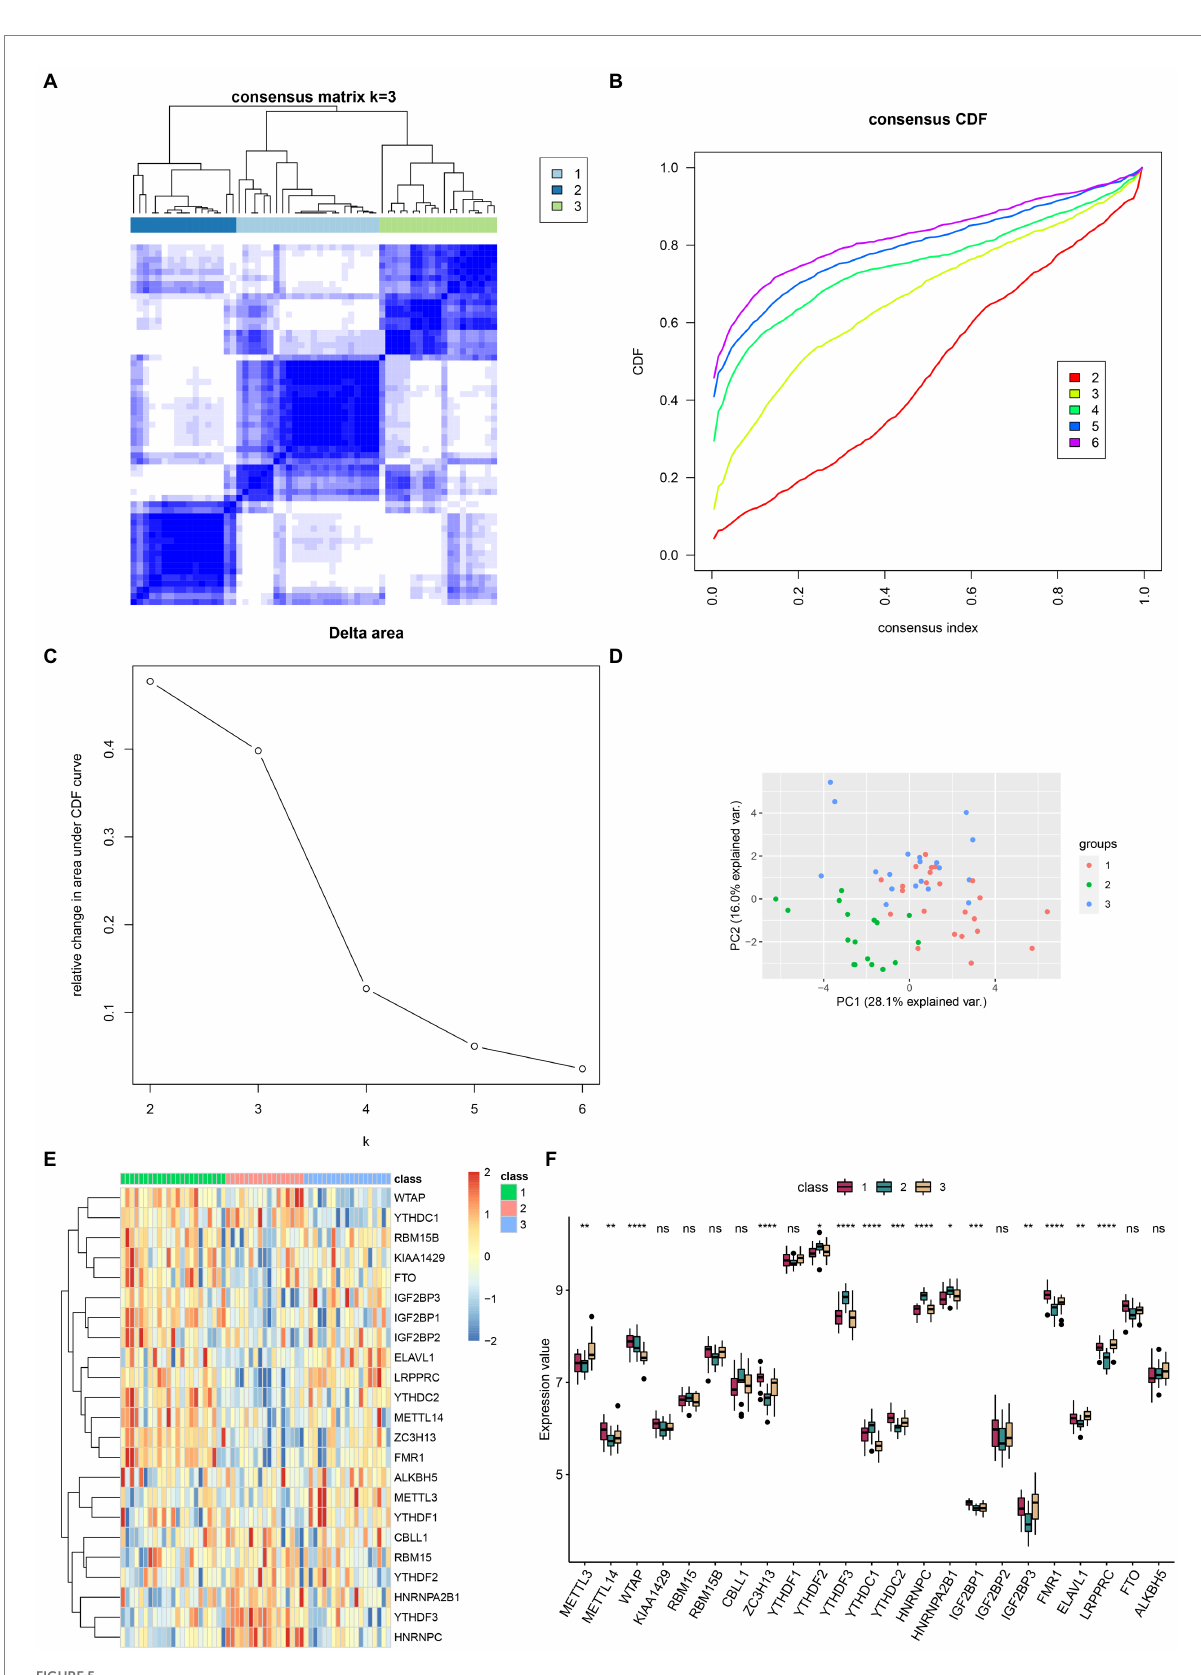
FIGURE 5 The three different subtypes of m6A regulator-mediated RNA methylation modification classes in IS were identified by unsupervised clustering of 23 m6A regulators. (A) Heatmap of the consistency matrix. (B) The cumulative distribution curve, with the gentlest slope of the curve